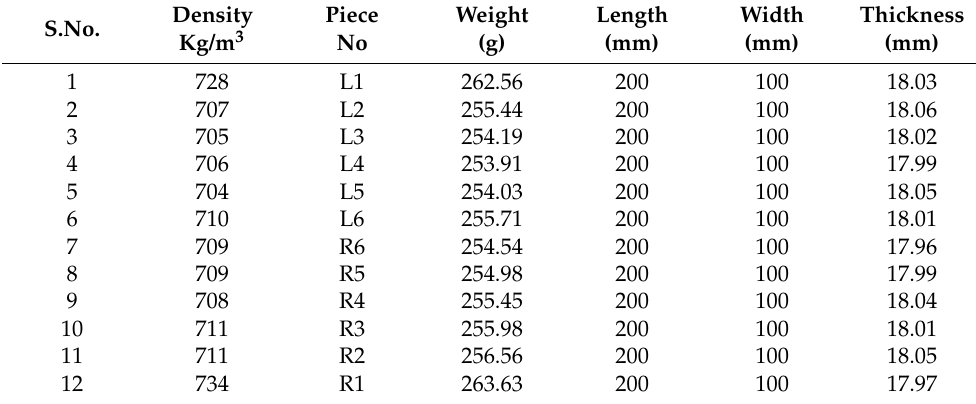
Table 16. Density profile across thickness.